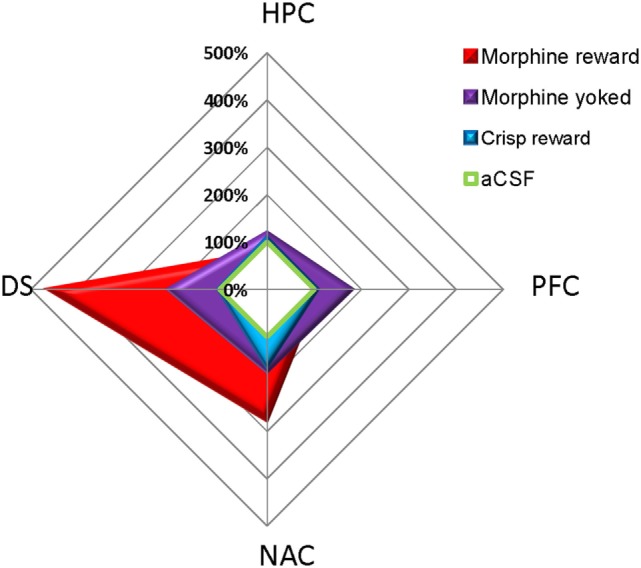
Summary of pCREB immunostaining changes relative to artificial cerebrospinal fluid (aCSF) animals (100%) 72 h after the last session of the Y-maze discrimination learning task. Previously drug (morphine) but not food (crisps)-rewarded animals exhibited a drastic and persistent increase in pCREB levels in the dorsal striatum (DS) and, although to a much lesser extent, in the nucleus accumbens (NAC) shell. In contrast, yoked controls exhibited an undifferentiated pattern of regional expression.